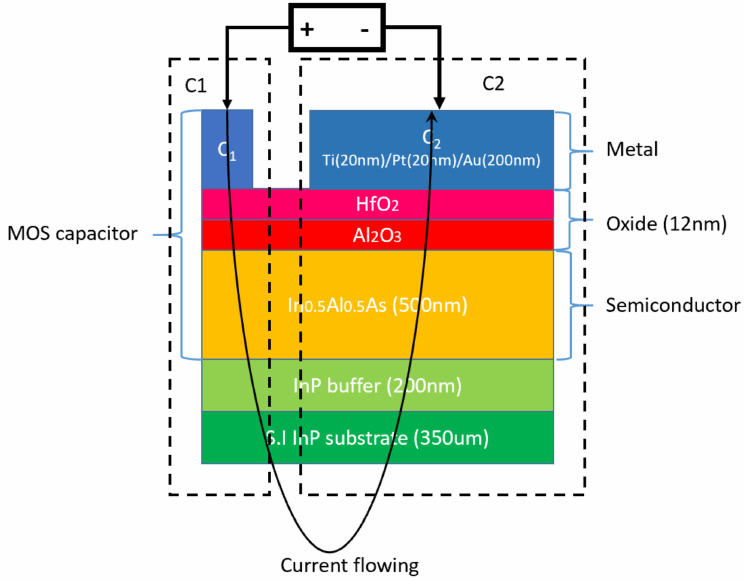
Figure 1. Structure diagram of the MOS